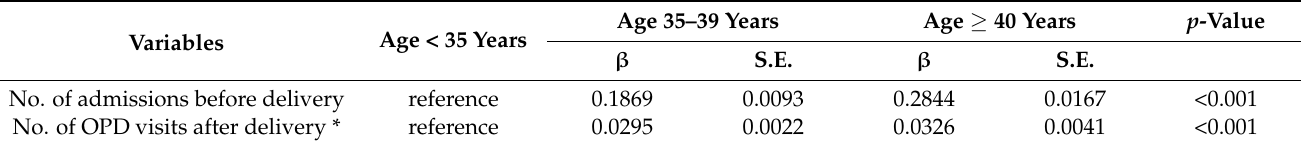
Table 4. Number of admissions and outpatient department visits.